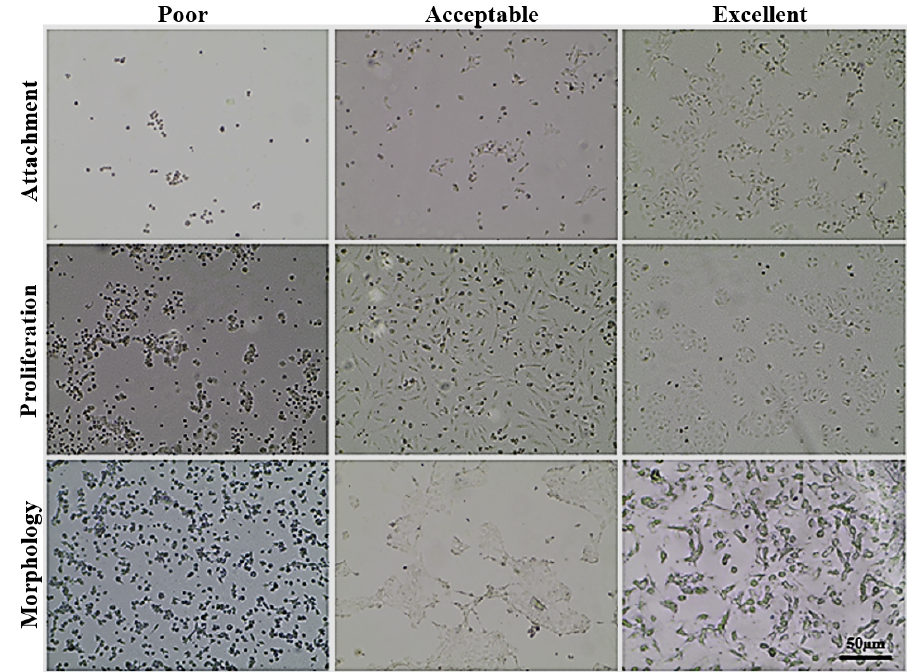
Figure 6. Representative images showing distinct cells attachment efficacy on LOC (mainly ana- lyzed after 24 h), proliferation efficiency, colonies formation, cells morphology, and signs of cell death, such as cells rounding and detachment (analyzed after 72–120 h).